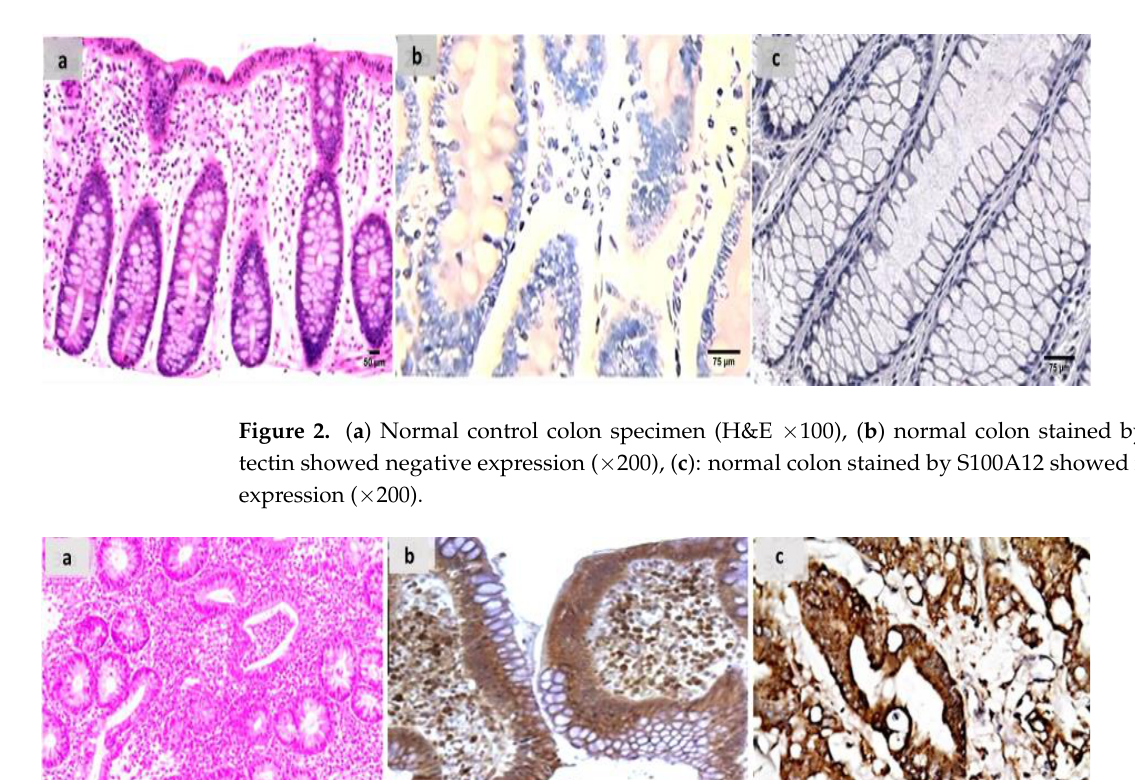
Note: UC, ulcerative colitis; TMAO, trimethylamine N-oxide; SCFAs, fecal total short chain fatty acids; FFAR-2, free fatty acid receptor 2, FFAR-3, free fatty acid receptor 3; TFAM, mitochondrial transcription factor A; Conc, concentration; ROS, reactive oxygen species. GSH, reduced glutathione; SOD, super oxide dismutase; NFkB, Nuclear factor kappa B; Nrf2, Nuclear factor (erythroid-2)- related factor 2; PGC1- α , Peroxisome proliferator- activated receptor γ co-activator 1 α . * p < 0.05 was considered statistically significant.